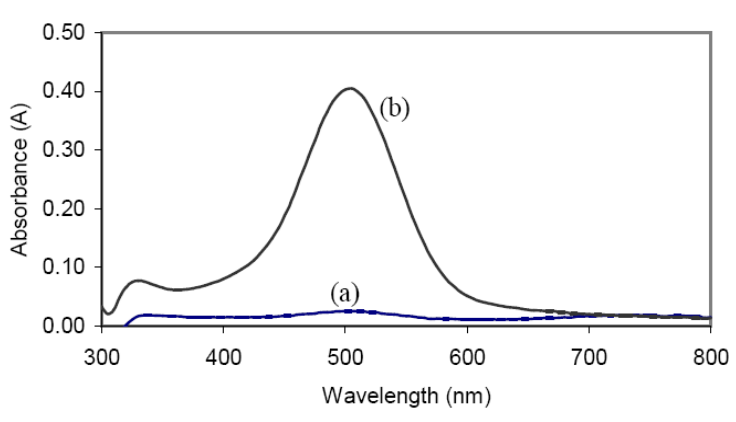
Figure 1 . Absorbance spectra of oxidation of catechol (25 mM) by laccase (0.004 unit/µL) in the absence (a) and presence of MBTH reagent (0.2 mM)